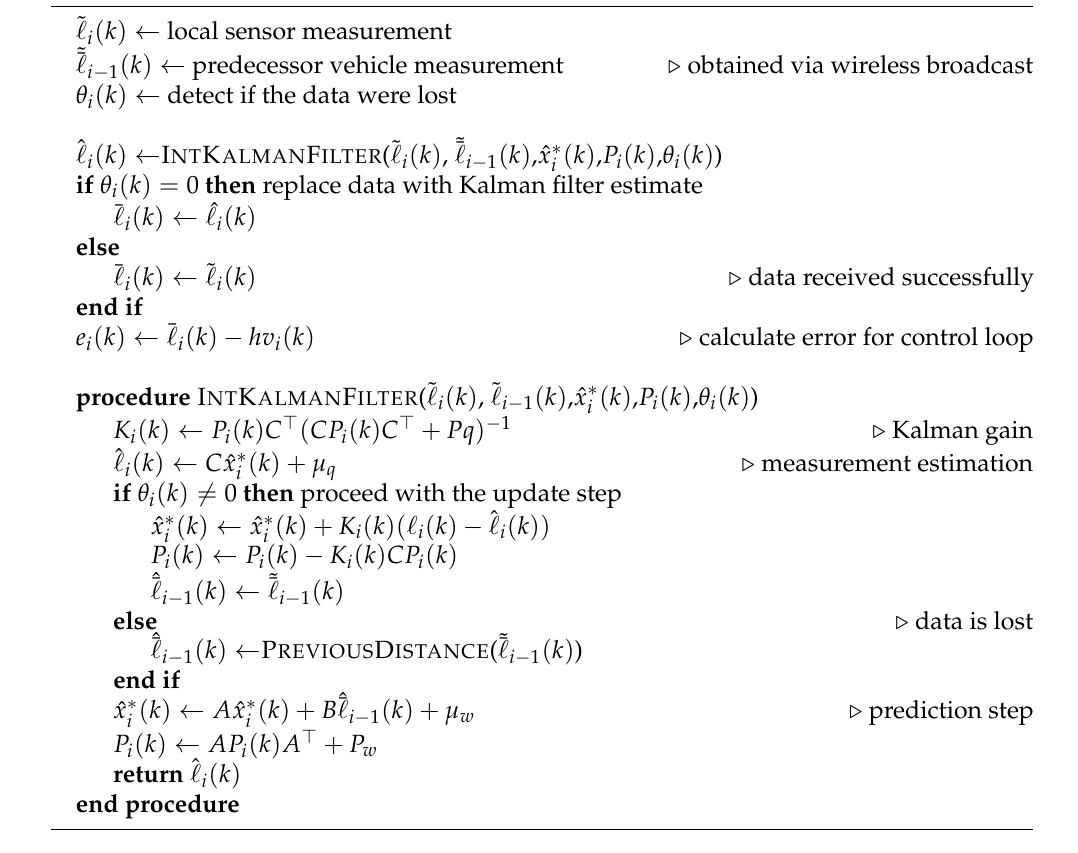
Algorithm 2 Data replacement using strategy based on intermittent Kalman